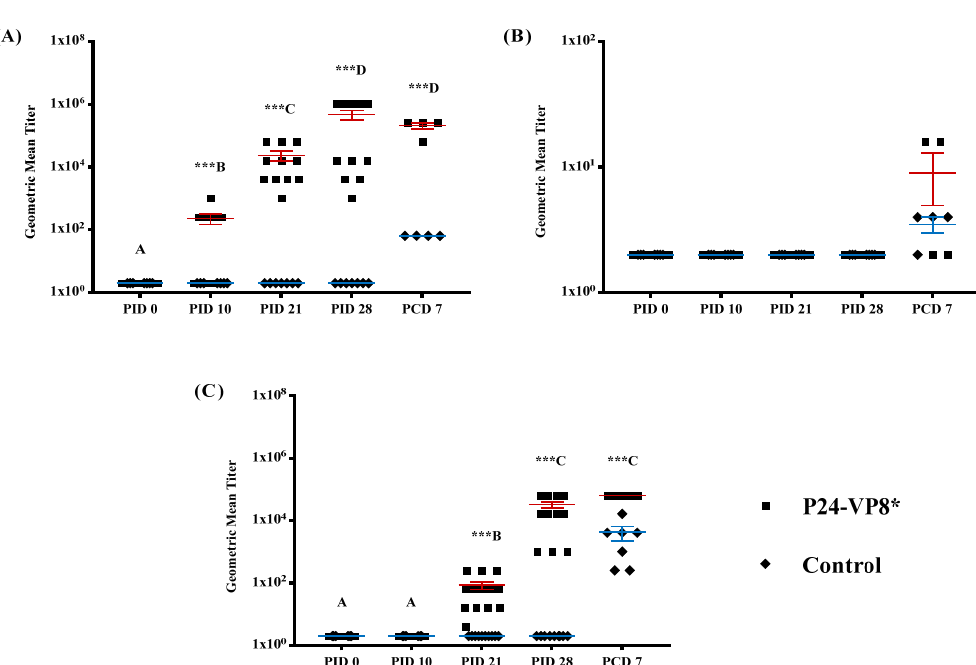
Figure 2. Geometric mean VP8*-specific IgG ( A ) and IgA ( B ) and Wa-HRV neutralizing ( C ) antibody titers in serum collected from Gn pigs at PID 0, 10, 21, 28, and PCD 7. Pigs were vaccinated with P24-VP8* vaccine or Al(OH) 3 adjuvant only. Each serum specimen was tested at an initial dilution of 1:4. Negative samples were assigned an arbitrary value of 2 for calculation and graphical illustration purposes. Comparisons between groups at the same time points were carried out using Student’s t -test and significant di ff erences are identified by *** ( n = 10–15; p < 0.001). Tukey-Kramer HSD was used for the comparison of di ff erent time points within the same group, where di ff erent capital letters (A, B, C, D) indicate a significant di ff erence, p < 0.01, and shared letters indicate no significant di ff erence.